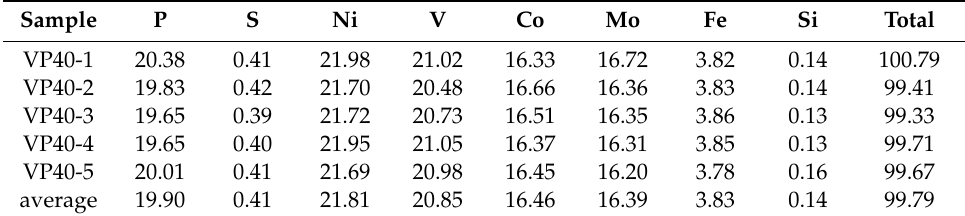
Table 1. Chemical data (wt % of elements) for